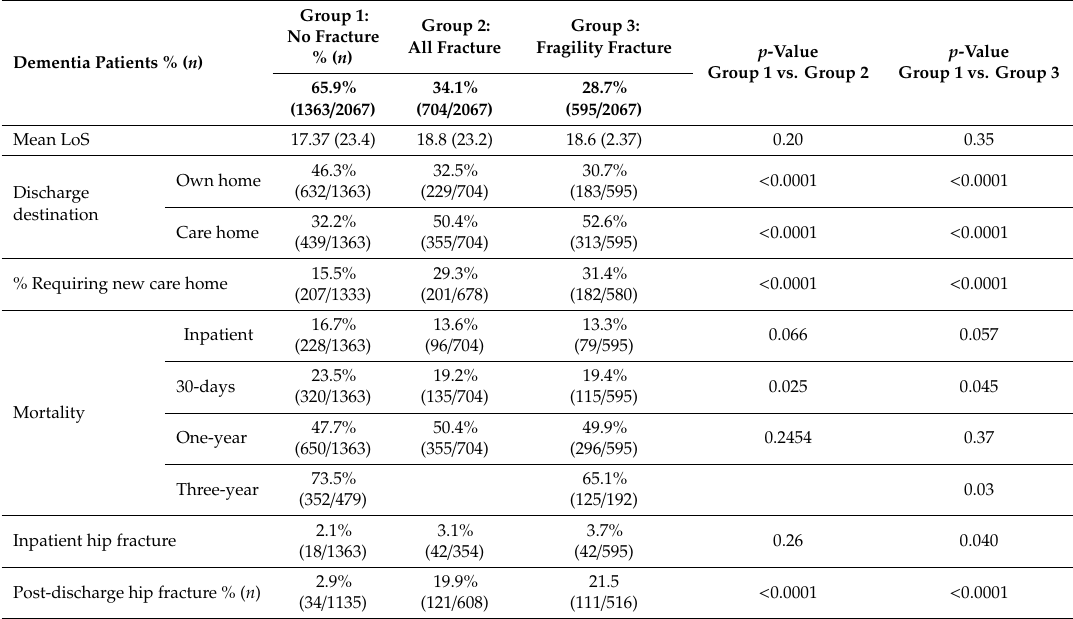
Table 2. Clinical outcomes and hip fracture data.